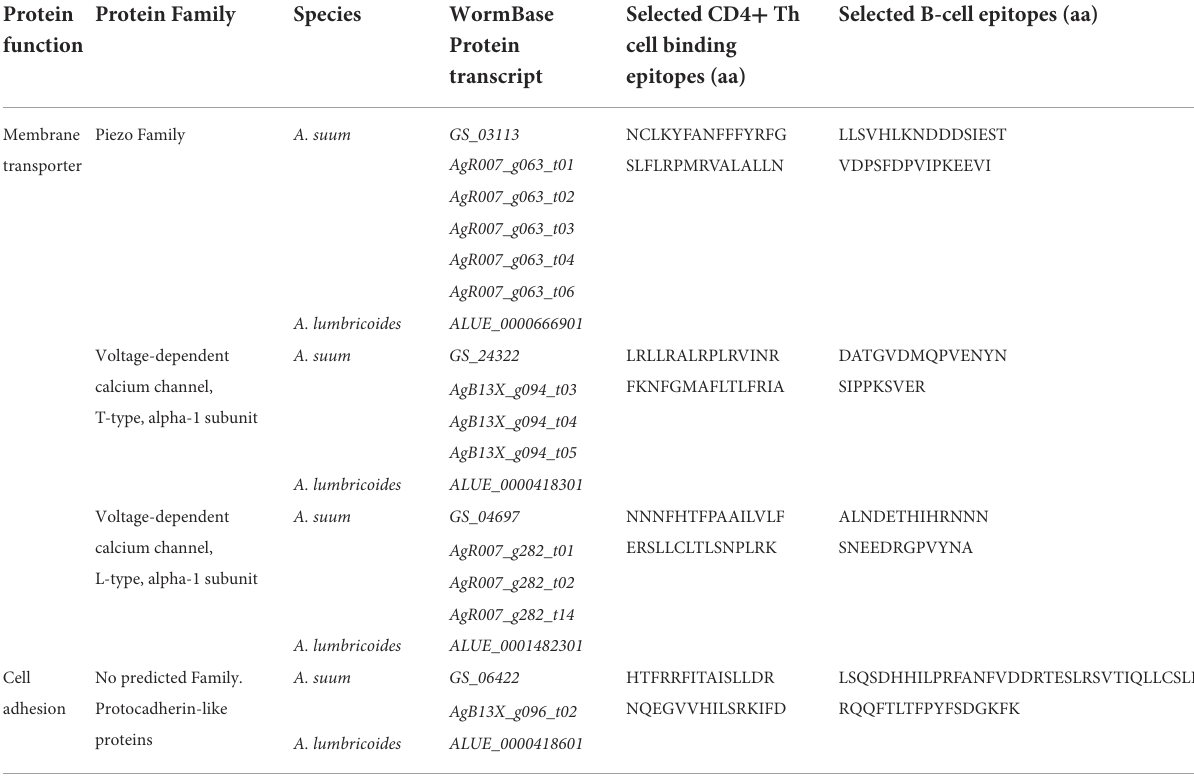
TABLE 1 Proteins and respective epitopes identified as potential vaccination targets against Ascaris spp. Protein